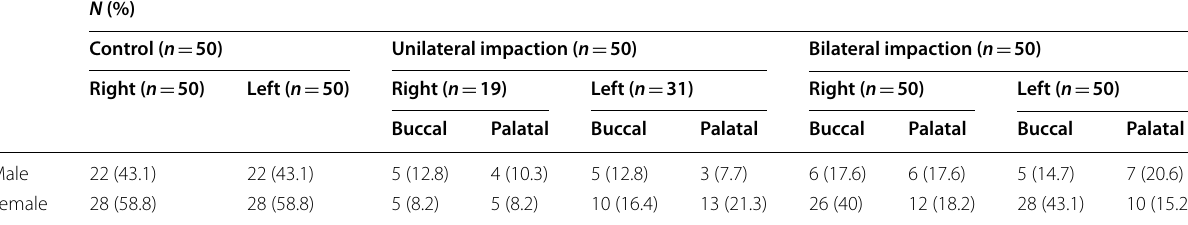
Table 3 Sex and side upper canine impaction distribution in each